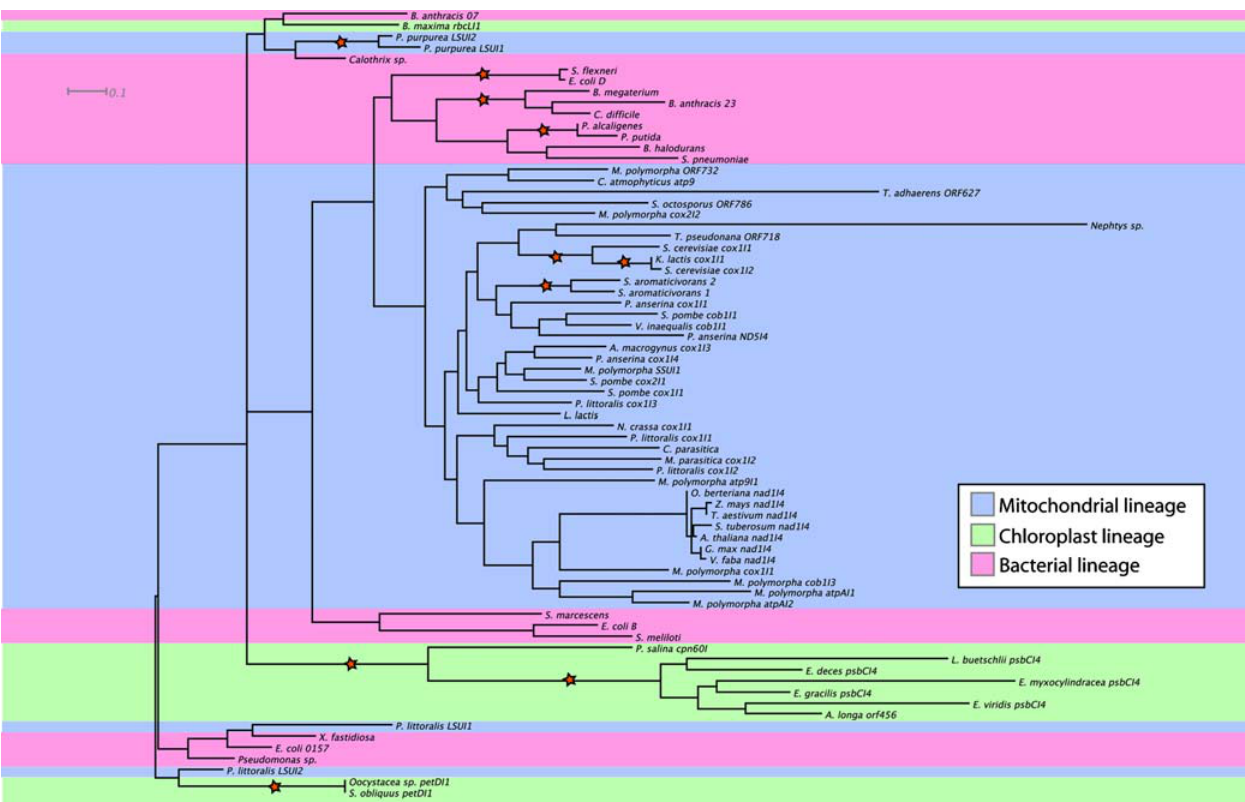
Figure 2. Phylogenetic analysis of 71 group II intron ORFs. A maximum likelihood analysis of the amino acid sequence for 71 ORFs suggests the cox1ORF718 of the marine centric diatom Thalassiosirapseudonanaas sister to the Nephtys’s ORF. Red stars indicate a bootstrap support $ 90. Names of taxa are indicated by the capital letter of the genus name, followed by species name and when applicable the intron location (specified in table